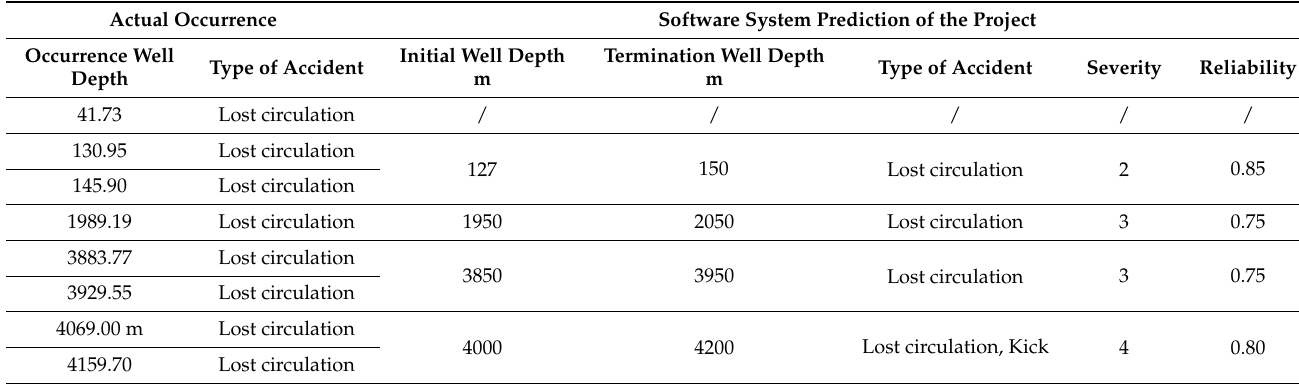
Table 4. Early warning result data of Yuanba well 11 accident.